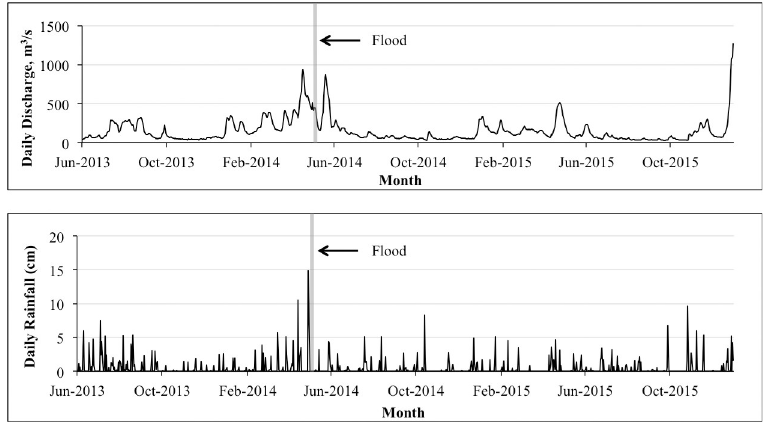
Fig 4. Daily rainfall and discharge data surrounding the flood event. Above: daily freshwater discharge from gauging flow station; Below: daily rainfall measurements; Data obtained from USGS Molino, FL flow gauging station (02376033) near the mouth of the Escambia